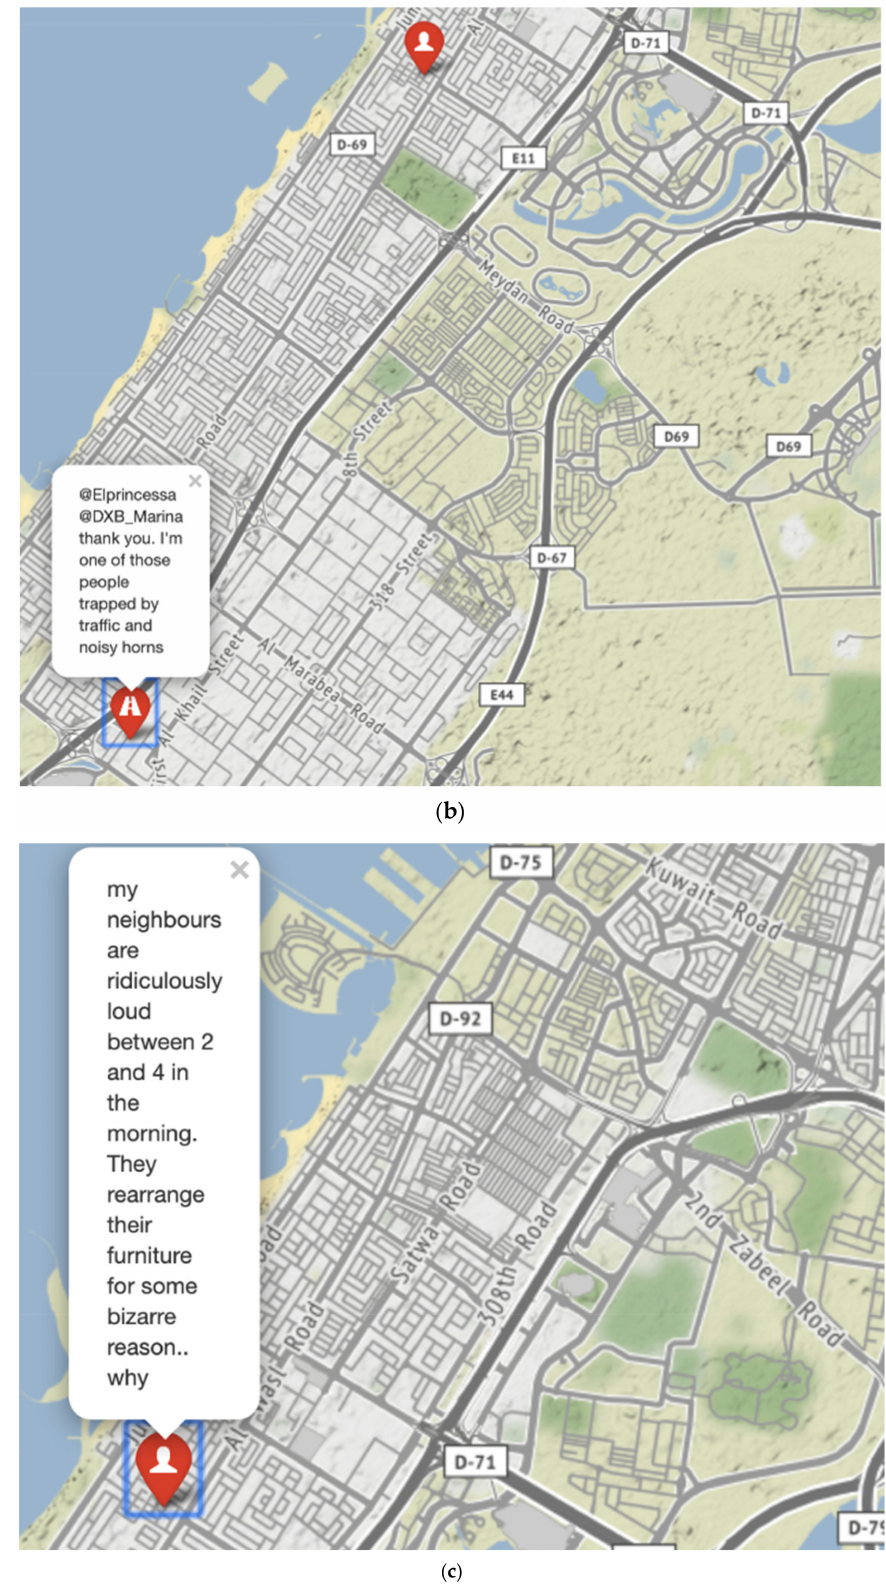
Figure 2. ( a ) Geolocation and characteristic of annoying noises, UAE Twitter 2015, blue = Abu Dhabi, red = Dubai, beige = Sharjah ( b ) reference to insert in ( a ): text “my neighbors are ridiculously loud between 2 and 4 in the morning. They rearrange their furniture for some bizarre reason”, ( c ) text “@Elprincessa @DXB_Marina thank you. I’m one of those people trapped by traffic and noise horns ”. Legend icons: musical note = music; tool = construction; person silhouette = human; road = traffic; airplane = airplanes; building services =